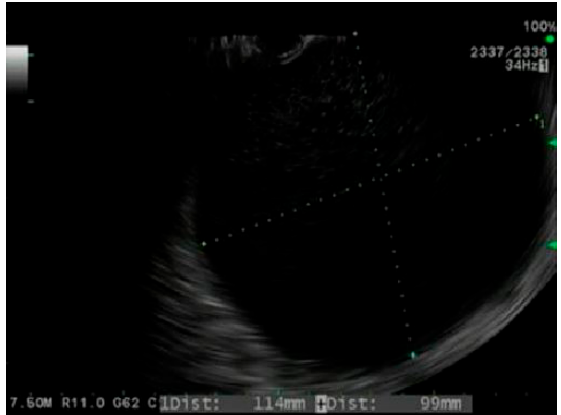
Figure 1. Endoscopic ultrasound image of a pseudocyst.